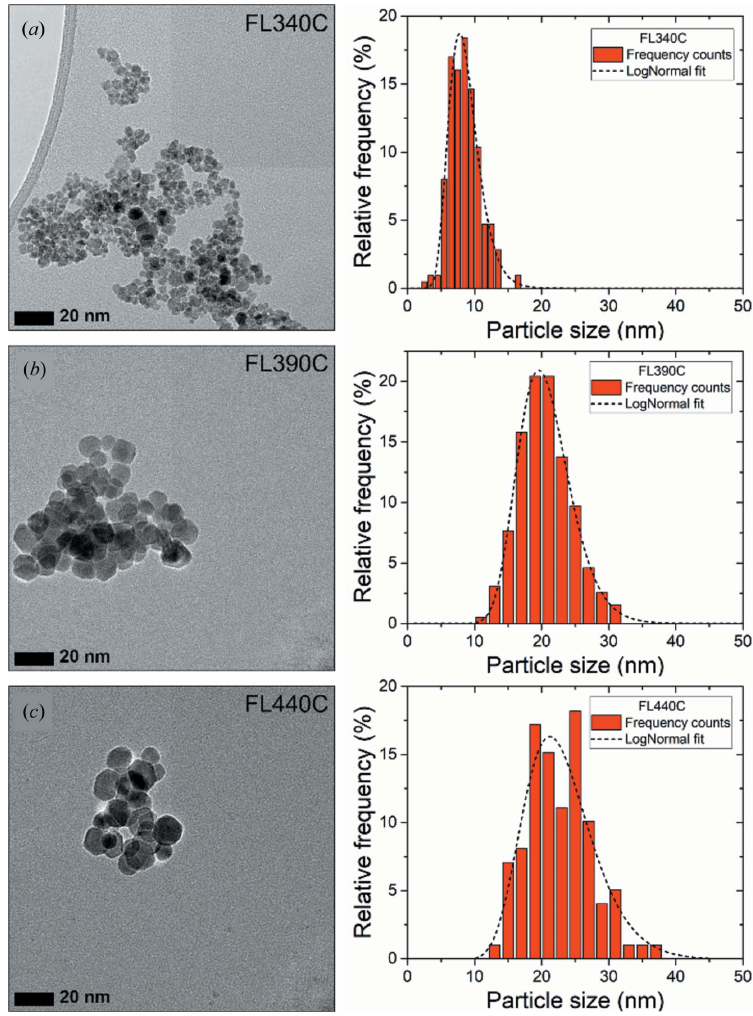
Figure 4 Representative TEM images and corresponding size analyses of the three iron oxide nanoparticle samples prepared at ( a ) 340, ( b ) 390 and ( c ) 440 (cid:4) C. The histograms have been fitted by a lognormal size distribution, as indicated by the dashed black line. Additional TEM images may be found in the Supporting